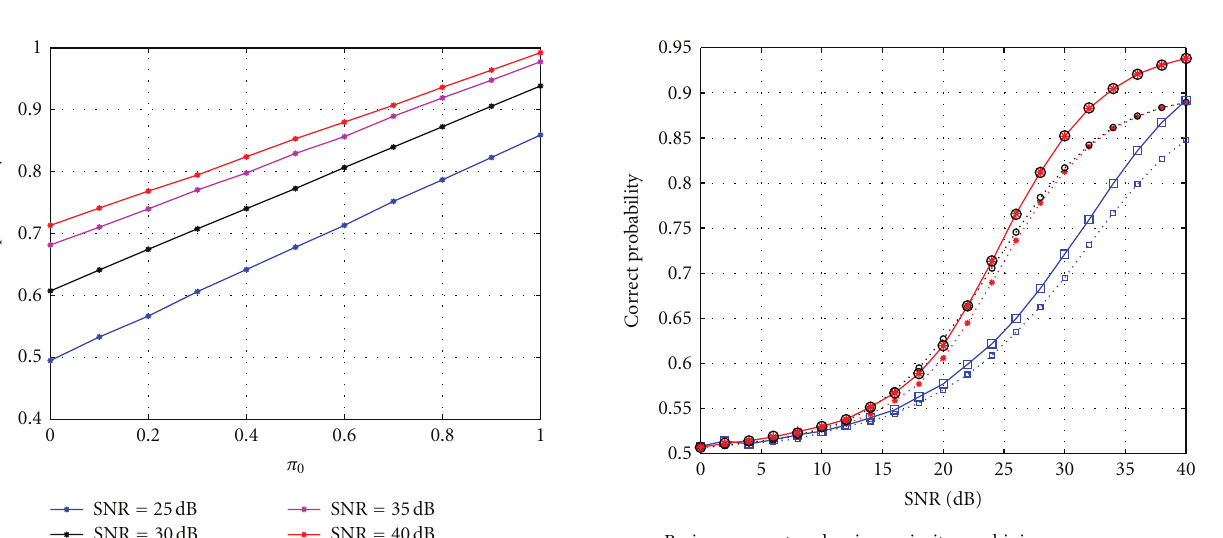
Figure 12: Simulated correct probability in di ff erent sensor net- works with 2-bit sensing results and majority combining rule in Rayleigh fading channels ( A = 0 . 9, β = 3 . 5, d =